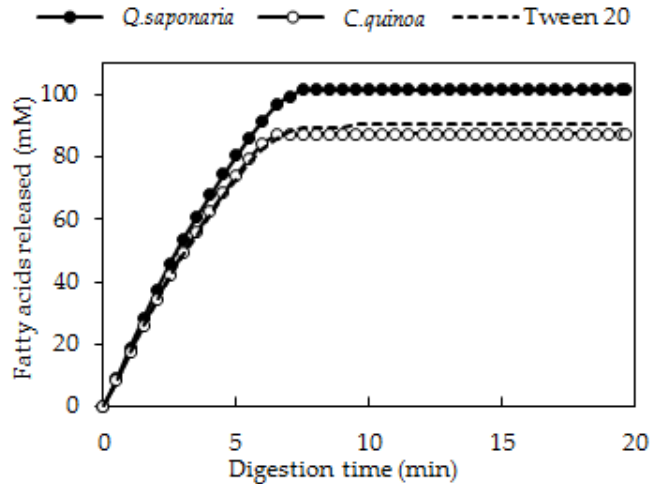
Figure 5. Fatty acids release curves generated during intestinal digestion for emulsions generated with ( • ) Quillaja saponaria , ( ) Chenopodium quinoa , or (–) Tween 20 as with ( ● ) Quillaja saponaria , ( ○ ) Chenopodium quinoa , or (--) Tween 20 as emulsifier. (cid:35)